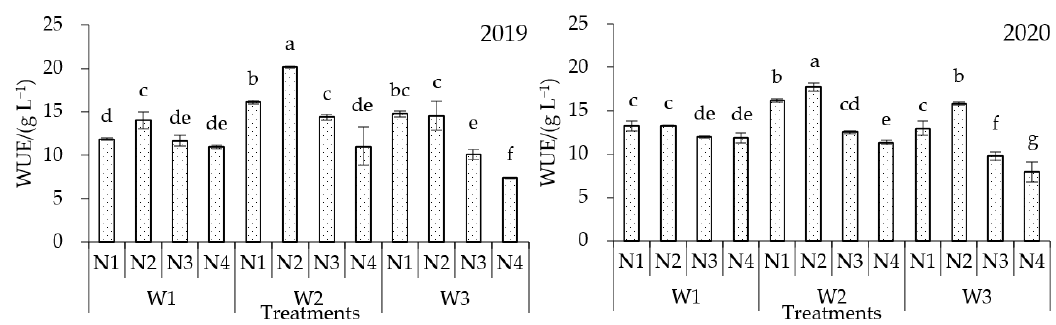
Figure 3. The water use efficiency of the green peppers in 2019 and 2020. Bars stand for standard error of the mean difference. Different small letters above the bars indicate a significant difference for various water levels and N treatments at p < 0.05 according to an LSD test within same year.